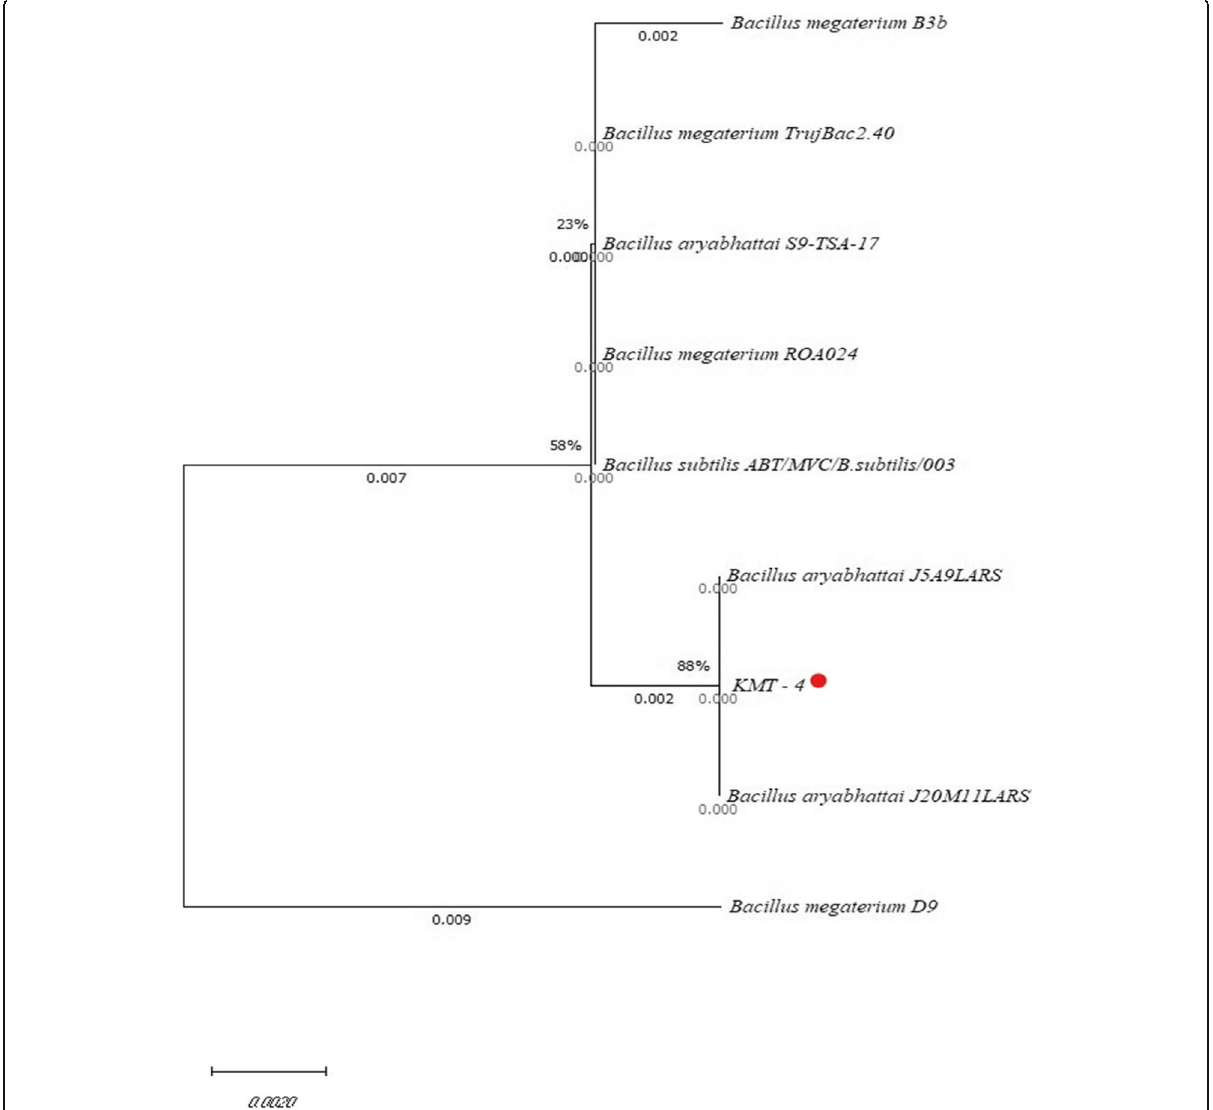
Fig. 1 Phylogenetic tree of Bacillus species based on analysis of the 16S rRNA gene sequences constructed by Maximum Likelihood method using MEGA X Table 1 Effect of Bacillus aryabhattai KMT-4 on hatchability of eggs masses of M. javanica in vitro